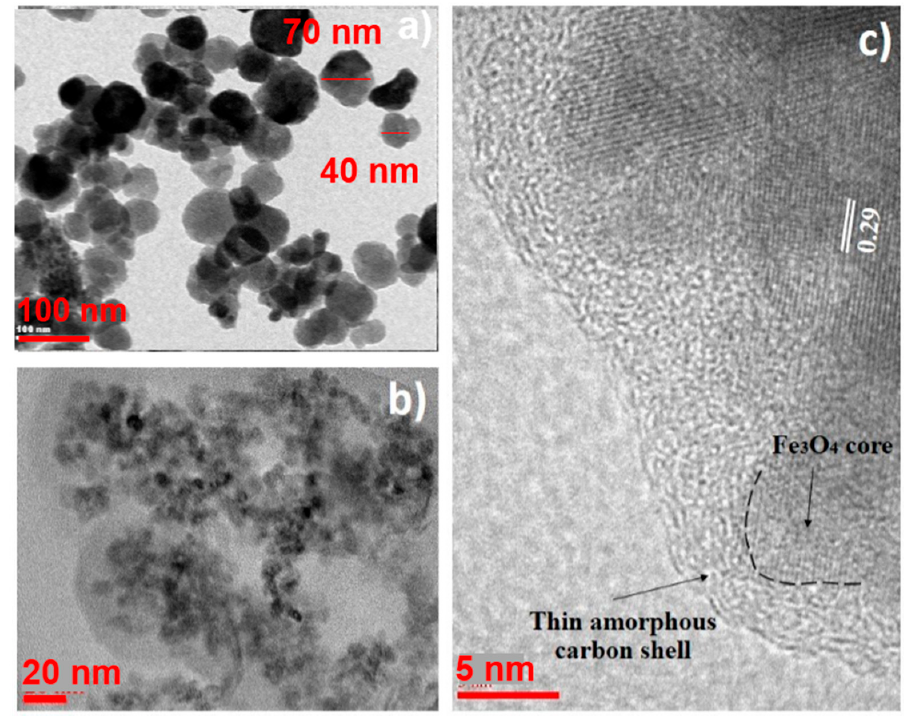
Figure 1. TEM images of ( a ) uncoated Fe 3 O 4 , ( b ) C@Fe 3 O 4 , and ( c ) C@Fe 3 O 4 . Appl. Sci. 2020 , 10 , x FOR PEER REVIEW